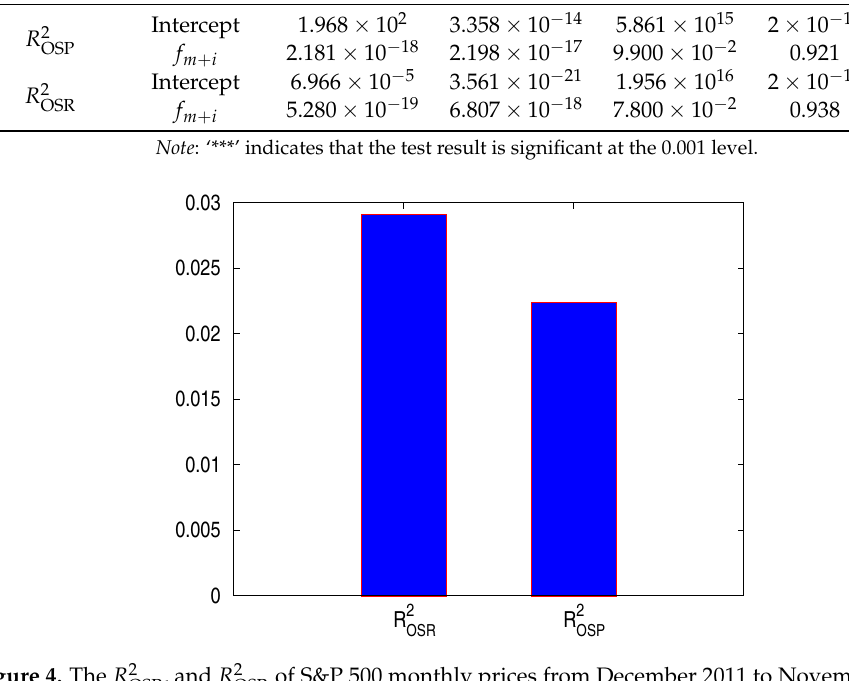
and R 2 . OSP OSR